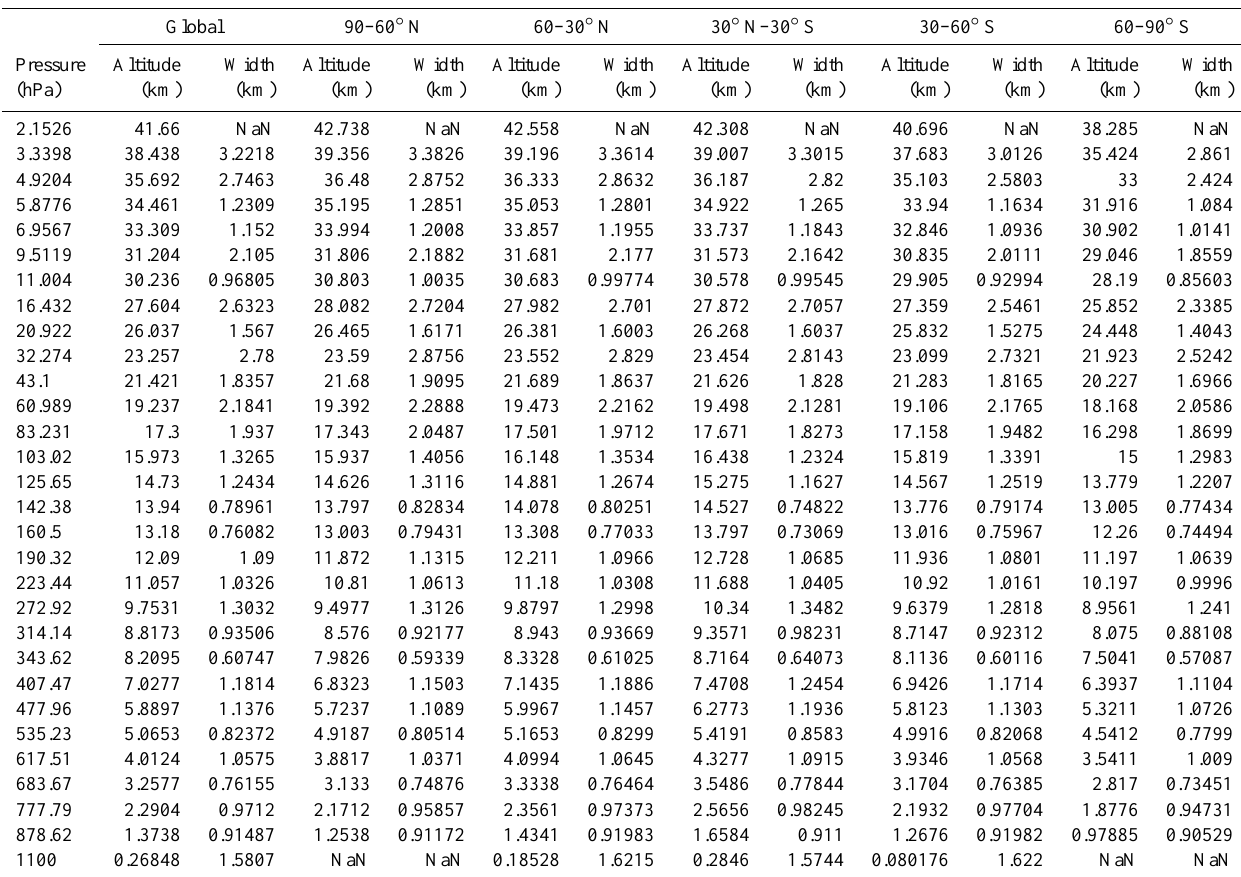
Table 1. Bottom bounding COSMIC mean sea level altitudes (km) and corresponding degraded layer widths (km) for selected latitude zones for the May 2012 COSMIC/AIRS matchup cases. Degrading was applied between set pressure levels of which the bottom bounding values are seen in the first